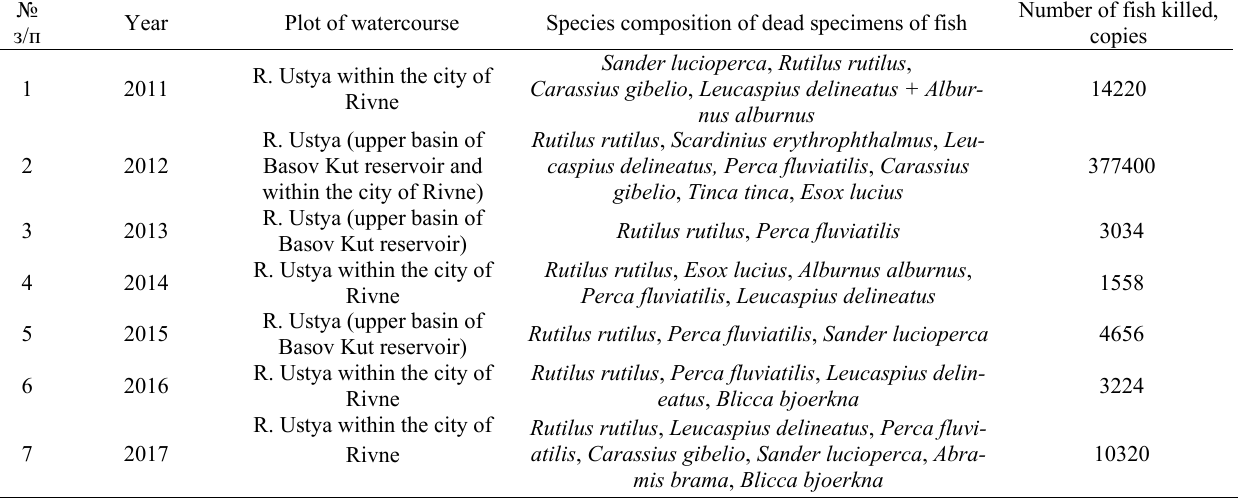
Results of accounting for dead fish on the Ustye River due to suffocation (according to the data of Rivne Fish Protection